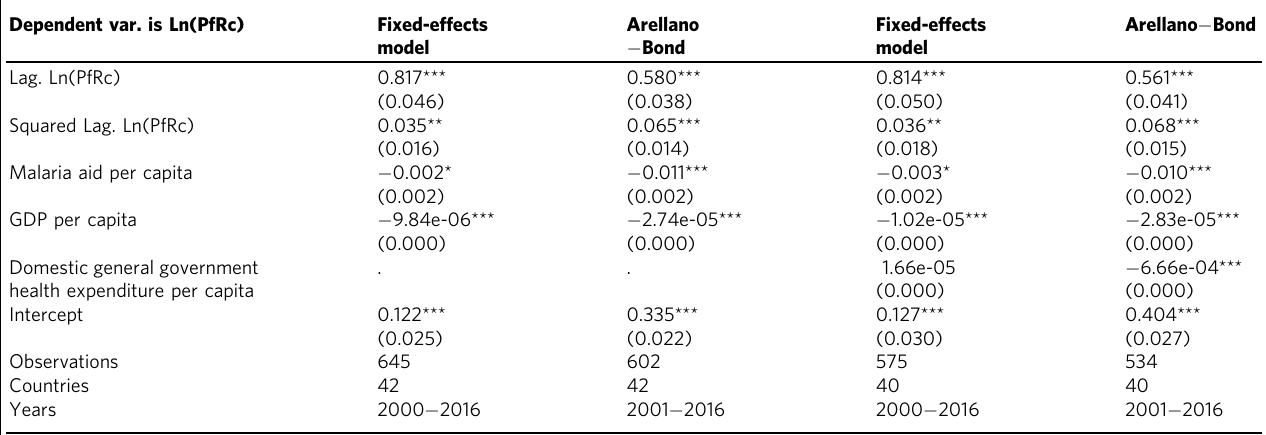
Table 1 Results from fi xed-effects and Arellano − Bond estimates of Eq. (4) Dependent var. is Ln(PfRc) Fixed-effects